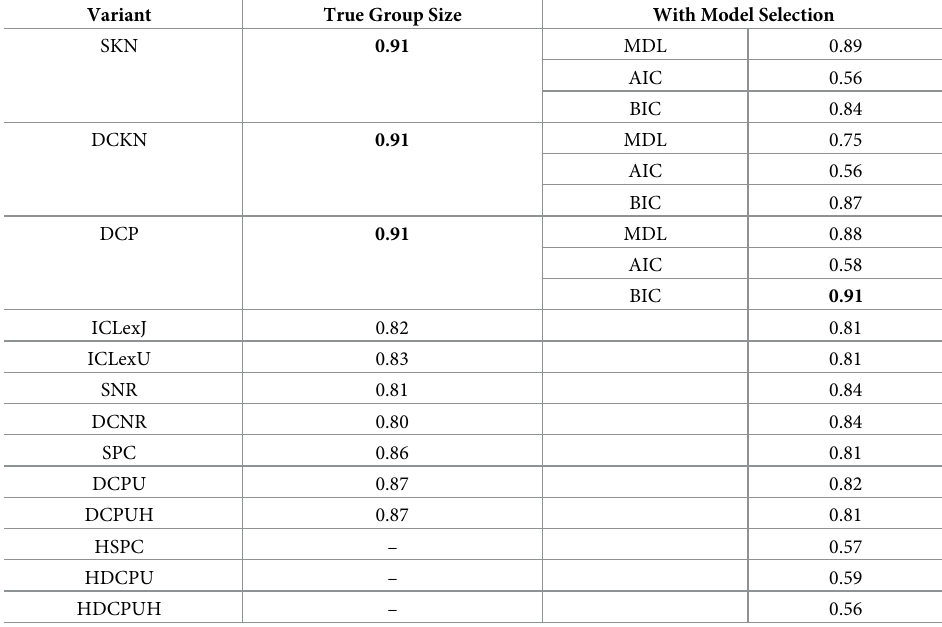
Table 2. Normalized AUMIC of the different SBM variants of the GN test for 0 � k out � 8 based on 10 executions of the MHA 50 000 from 10 random partitions for each group size K = 1, ... , 10 and each k out = 0, 0.5, ... , 8. Variant True Group Size With Model Selection SKN 0.91 MDL